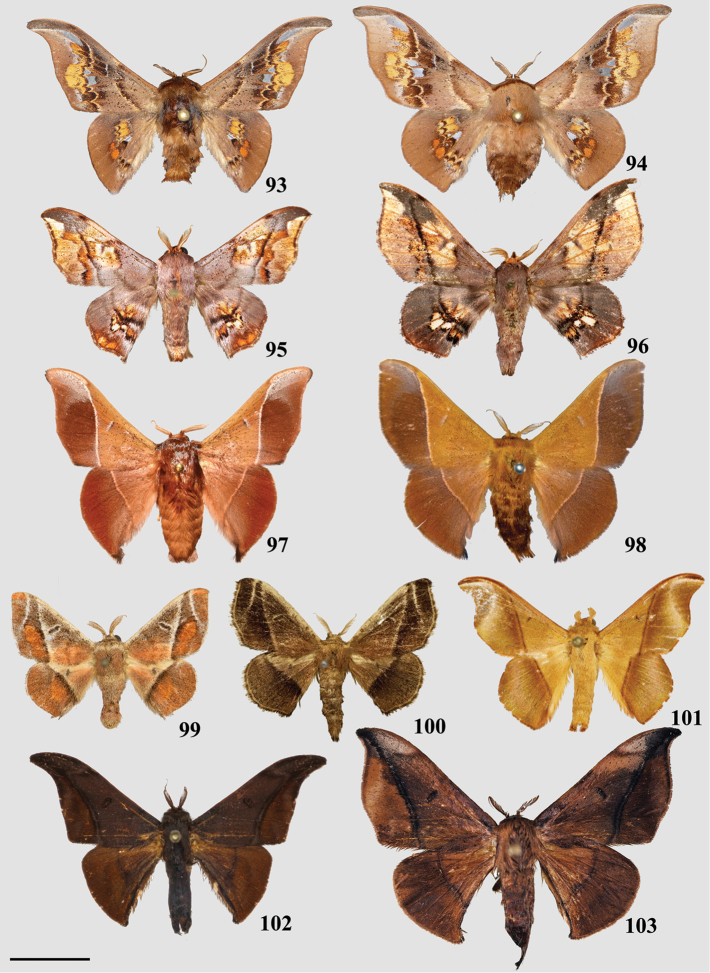
Adult specimens of type species of genera belonging to Lacosominae: Alheitini. 93Adalgisacroesa, male (CGCM) 94A.croesa, female (CGCM) 95Arianulahaxairei, male [photo R Lahousse] (MNHN) 96A.haxairei, female [photo D Herbin] (CDH) 97Herbinallacaudina, male [reused with permission from St Laurent et al. (2018a), Systematic Entomology] (CGD) 98H.caudina, female [reused with permission from St Laurent et al. (2018a), Systematic Entomology] (MJWC) 99Taremarivara, male [photo A Prozorov] (MWM) 100T.rivara, female (USNM) 101Alheitaanoca [reused with permission from St Laurent et al. (2018a), Systematic Entomology] (NHMUK) 102Thaelialinamariae, paratype male [photo R Lahousse] (MNHN) 103T.linamariae, female [photo R Lahousse] (MNHN). Scale bar: 1 cm.